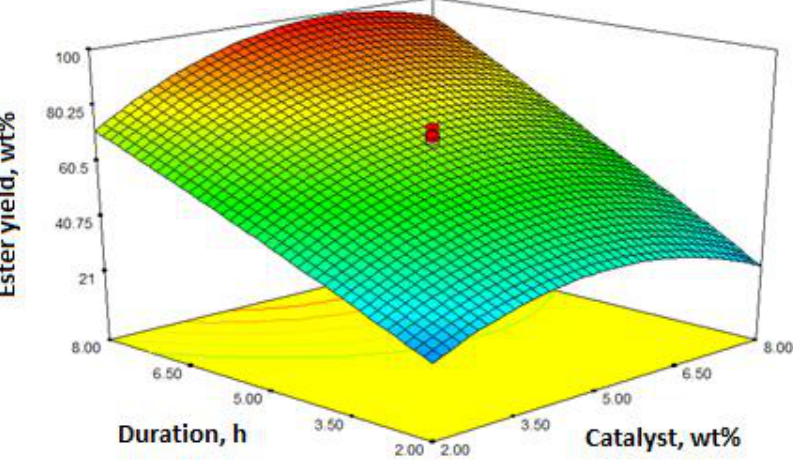
Figure 4. Response surface contour plot for the interaction between the processing time and the catalyst at 64 °C with a methanol-to-oil molar ratio of 8:1.